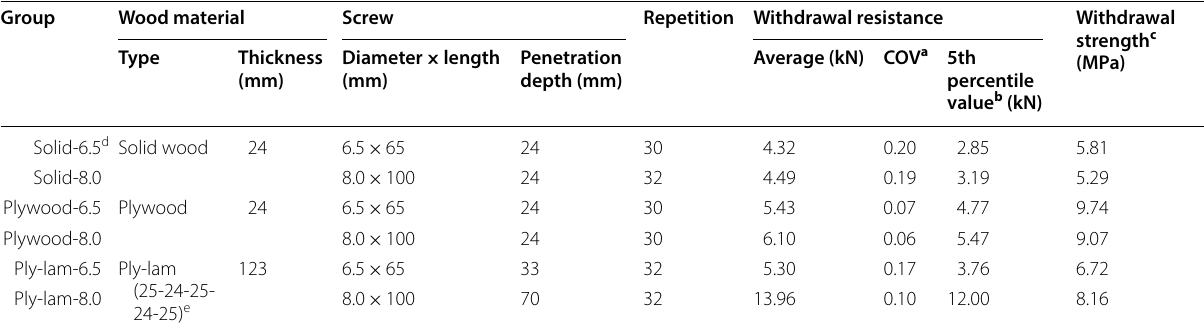
Table 3 Specimens and test results depending on the test configurations